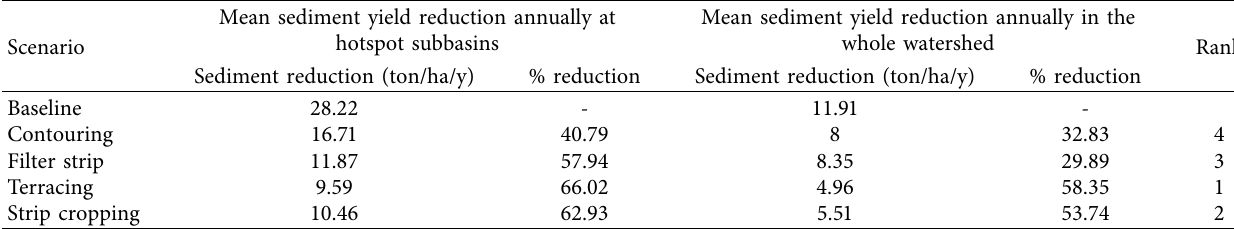
Table 4: Outline of scenarios compared with baseline